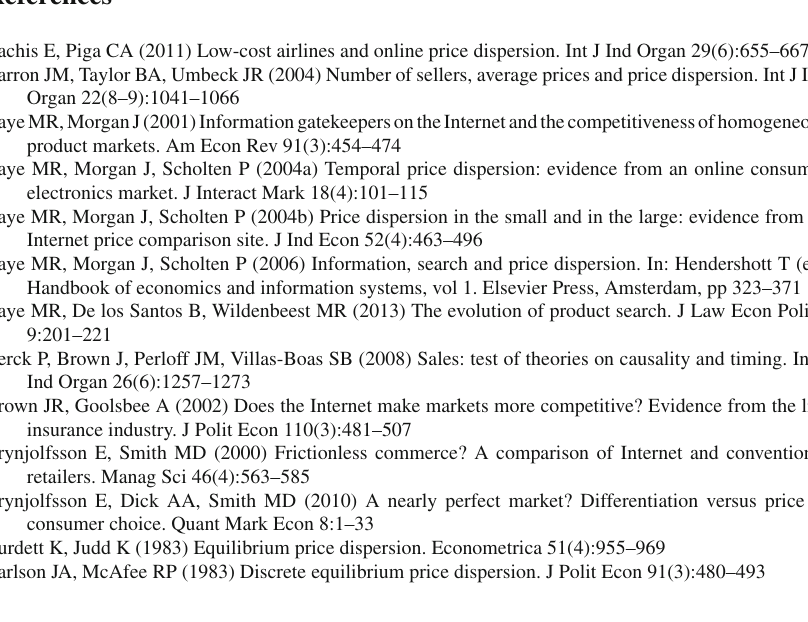
Coefficient of variation ( ×